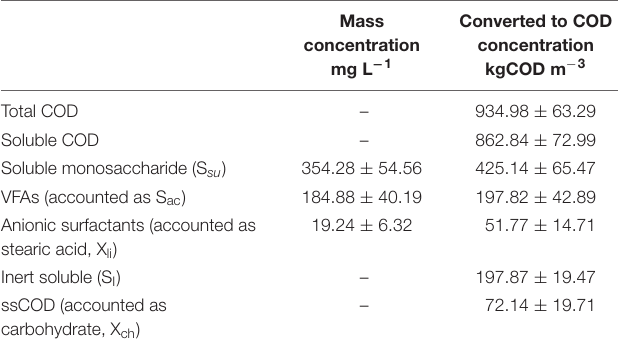
TABLE 1 | The main component content and COD concentration conversion of DIP